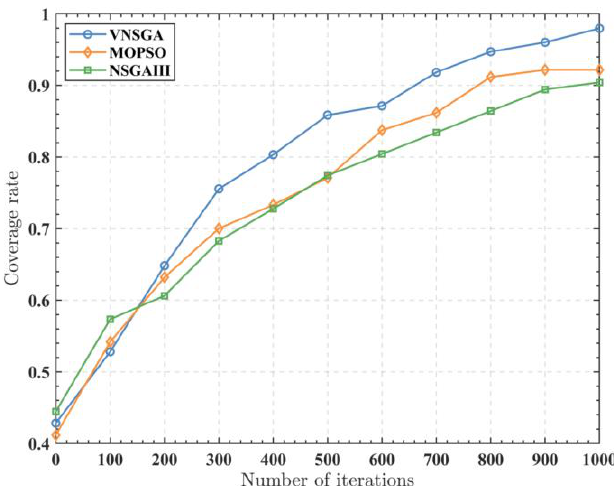
Figure 25. Coverage rate for three algorithms with different iterations with respect to area B.